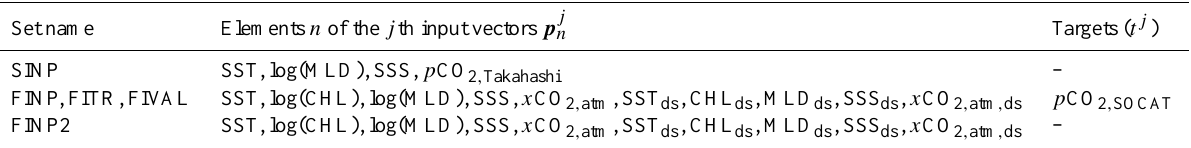
Table 1. Input and target vector elements for each subset used within our method. The subscript ds describes deseasonalized data, which are computed by subtracting the long-term mean seasonal cycle from the original data set as explained in the text. Additionally, log(CHL) was excluded from sets FINP, FITR, FIVAL and FINP2 to estimate p CO 2 when no satellite chlorophyll a was available due to cloud cover.